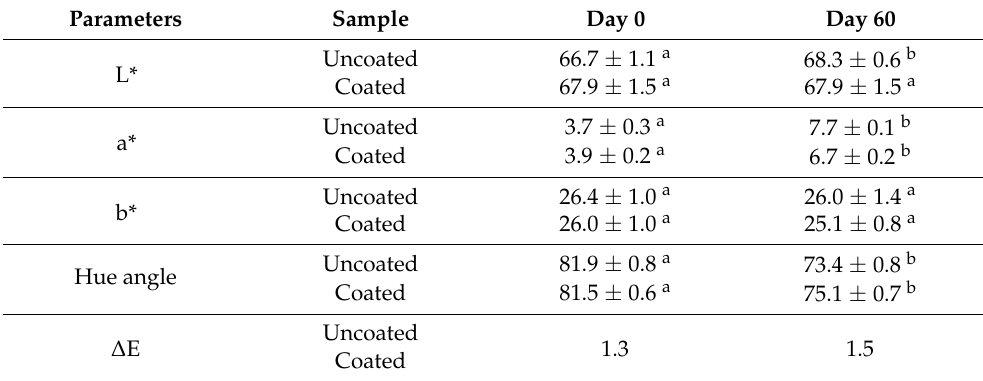
Table 2. Color attributes of uncoated and coated Paipa cheese samples. Parameters